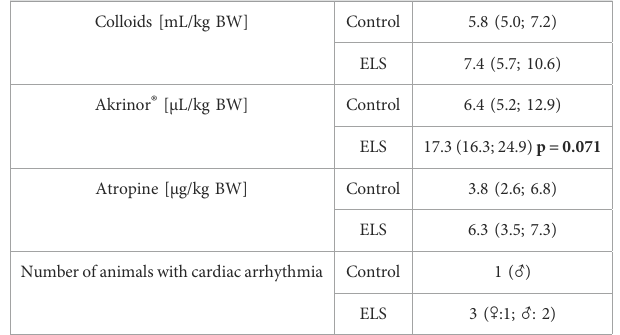
TABLE3Bloodcellcountinthecontrol(n=5)andEarlyLifeStress(ELS)groups (n = 6). Data are median (interquartile